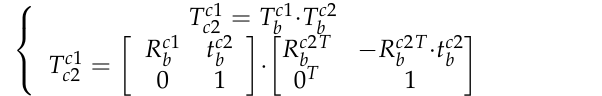
Figure 13. Structure diagram of binocular stereo panoramic calibration.